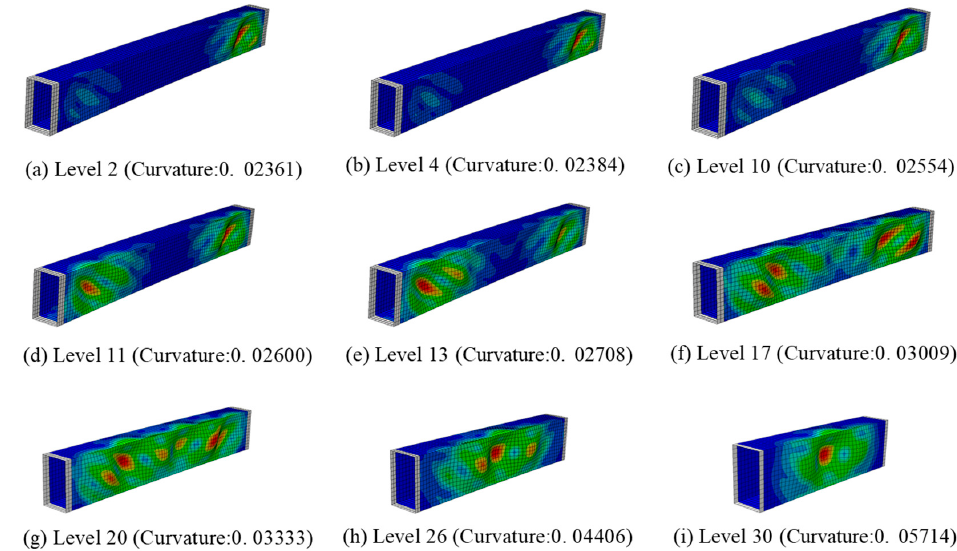
Figure 27. The buckling shapes for the perimeter beams with different curvature.